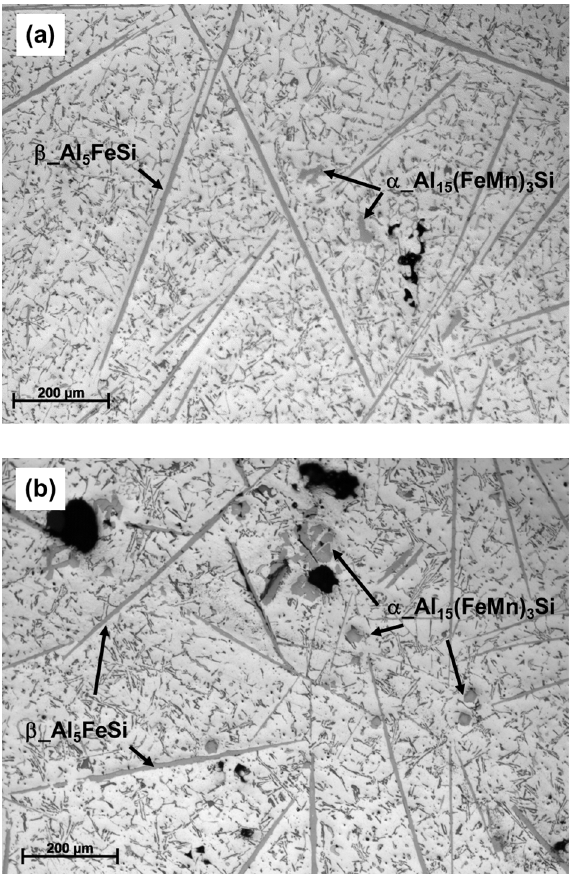
Figure 6. Optical micrographs showing the Fe-containing intermetallics in solidified A380-0.2Mn-2Fe alloy ( a ) without HSMC; and ( b ) after HSMC in the solidified samples. Circ. = 4𝜋𝐴/𝑃 (cid:2870) (2)